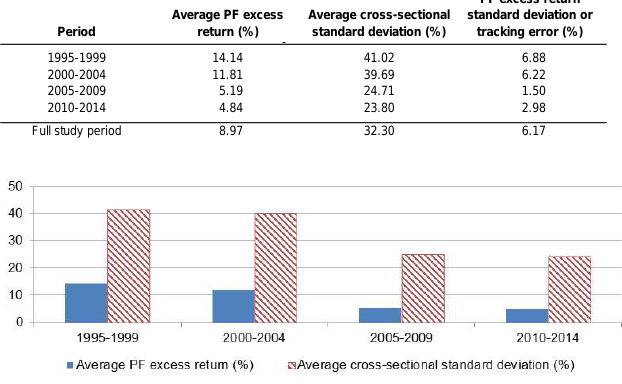
Table 2: PF excess return and cross-sectional standard